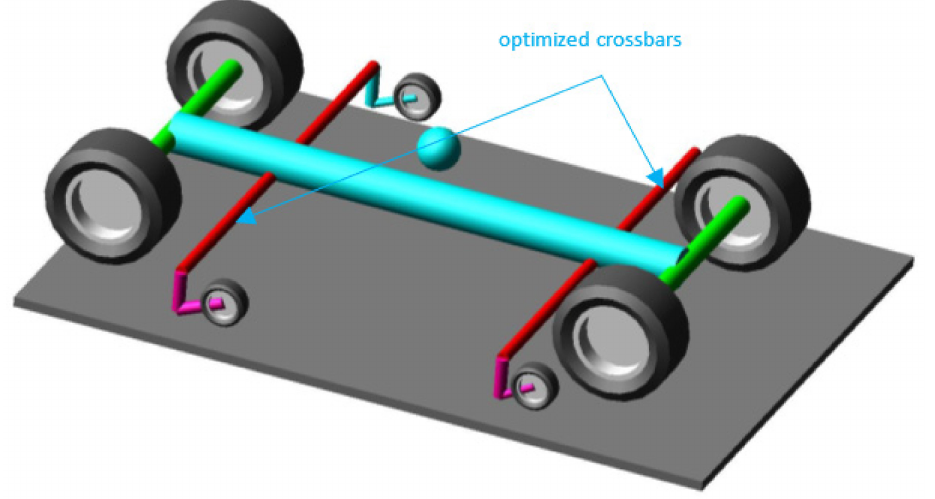
Figure 2. Vehicle model with ASC to determine the load.